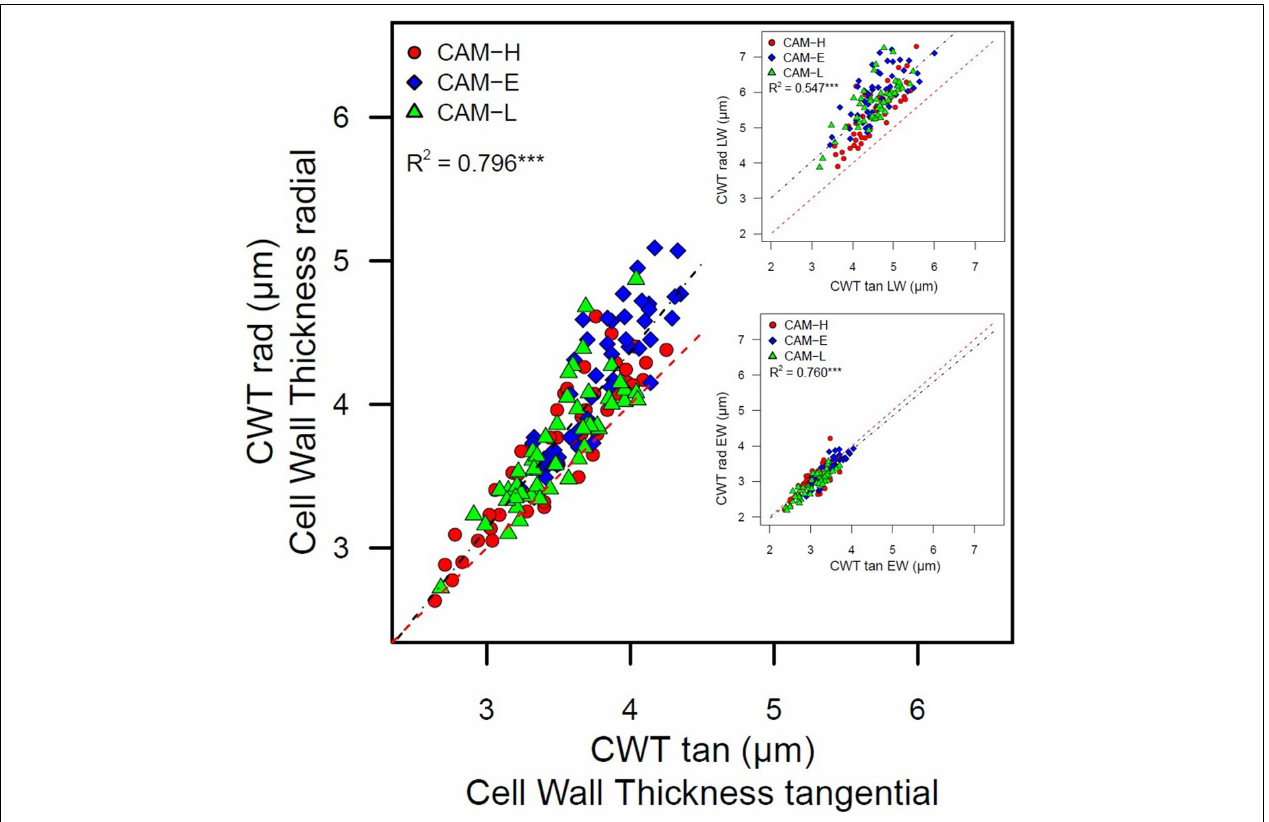
FIGURE 6 | Cell wall thickness in radial direction (CWT rad) as a function of cell wall thickness in tangential (CWT tan) direction. The inset figures represent the same relationship for EW and LW portion. Each symbol (circle, diamond, and triangle) corresponds to trees from the three plots CAM-H (red), CAM-E (blue), and CAM-L (green). The linear regressions are significant (*** P < 0.001). The dashed red line represents the 1:1